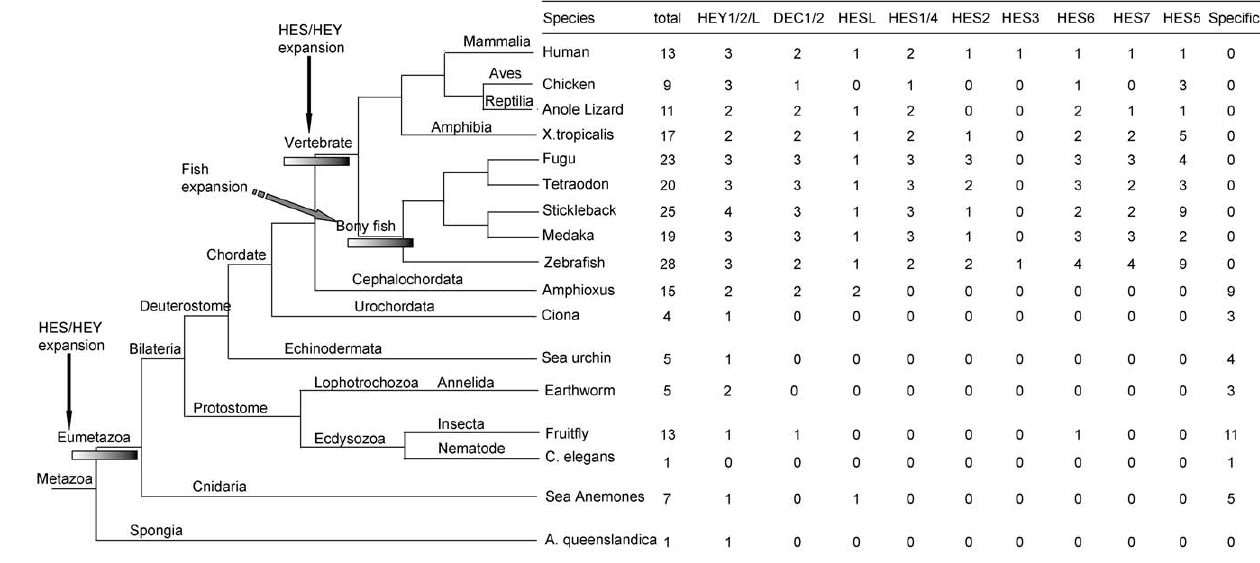
Figure 1. Two round expansions and a fish specific duplication of HES/HEY in all the species. The phylogenetic relationship of all the species investigated is in the left. The number of HES/HEY genes is in the right. Two round expansions and a fish specific duplication of HES/HEY are represented by arrows and bars.